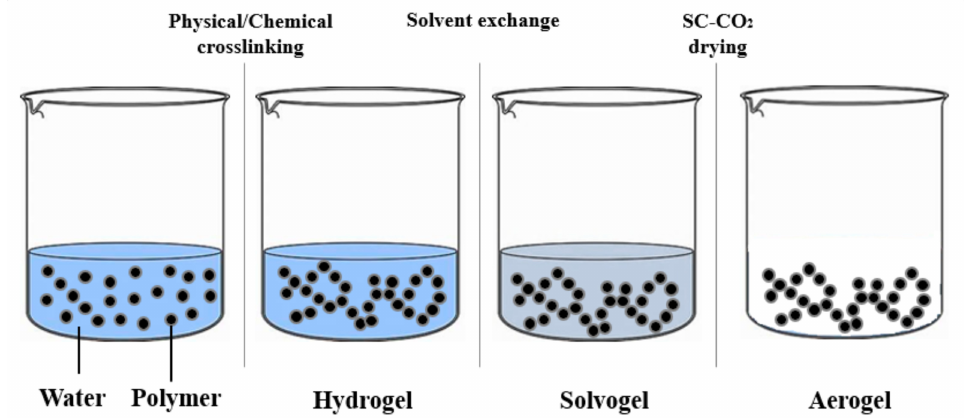
Figure 2. Hydrogel–solvogel–aerogel